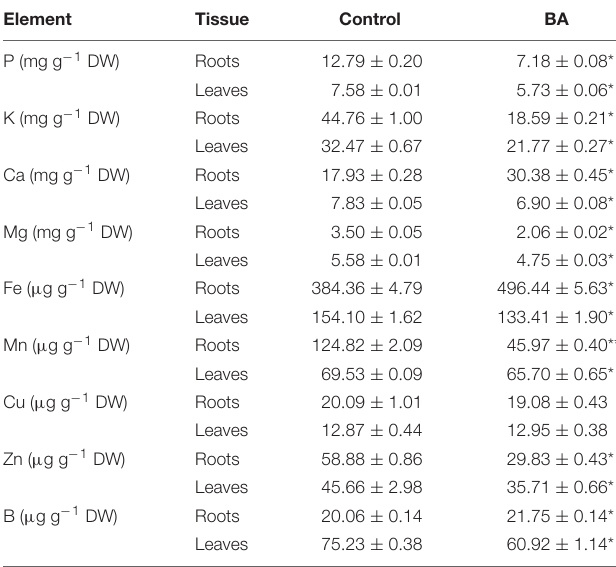
TABLE 1 | Effects of BA stress on mineral contents in roots and leaves of peach seedlings. Element Tissue Control